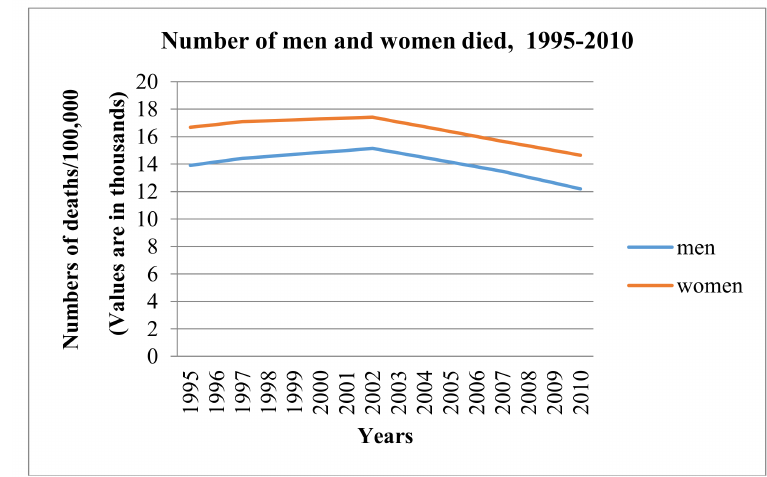
Figure 1. Number of deaths (men and women),